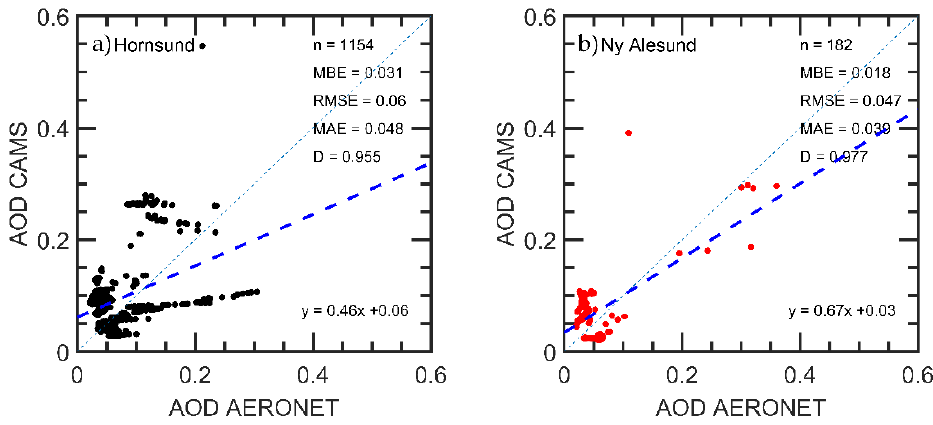
Figure 15. Scatterplot of AOD by CAMS models vs. AOD by AERONET level 2.0 data in two sites: ( a ) Hornsund and ( b ) Ny-Ålesund. Dashed blue lines are the linear fits.